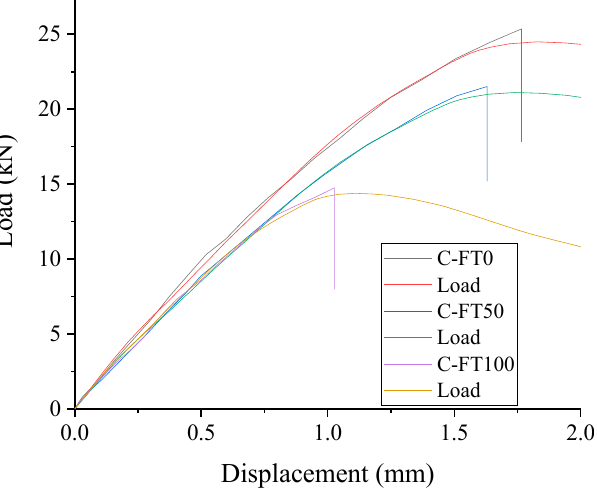
Figure 21. Comparison of flexural load curves of specimens without reinforcement under freeze-thaw action.